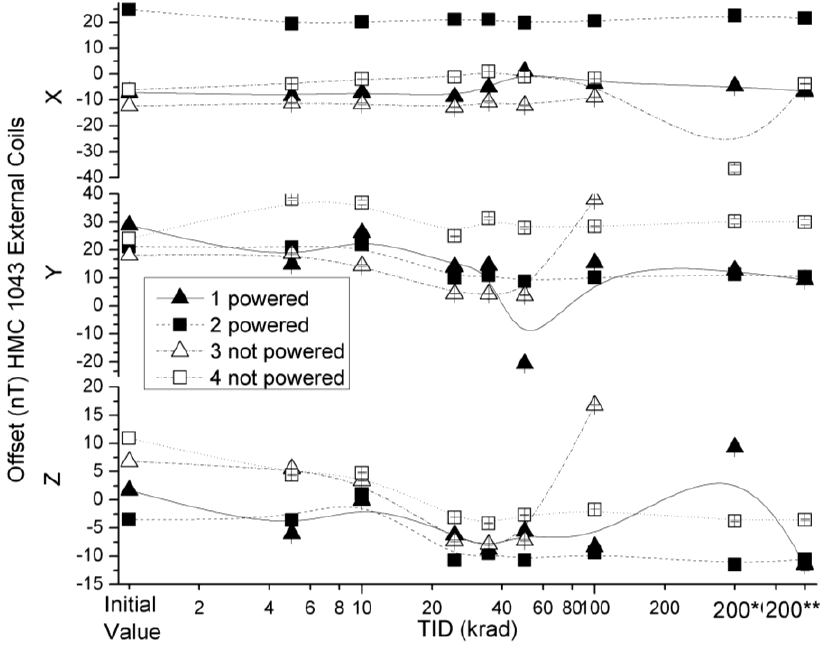
Figure 8. Measured offsets in external coils configuration as a function of TID for powered and non-powered HMC 1043.